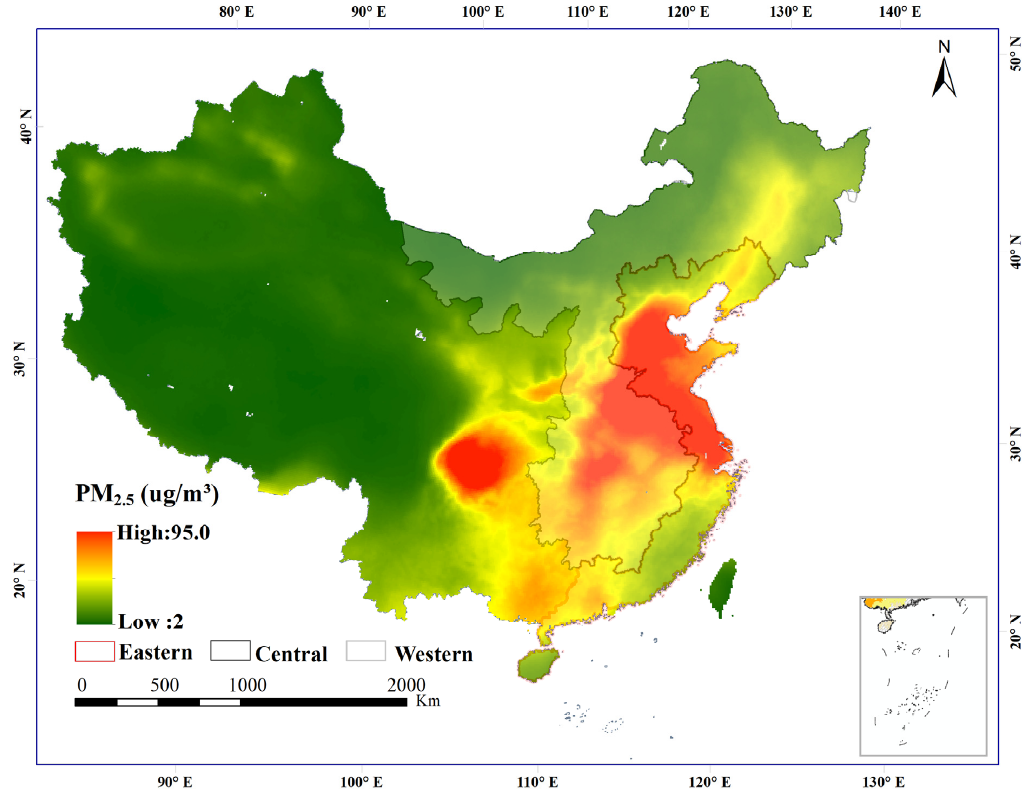
Figure 3. The spatial distribution of the annual average anthropogenic PM 2.5 concentrations in China during 1998–2016. (We used ArcGIS 10.2 software to calculate the average mean of the gridded data of anthropogenic PM 2.5 concentrations from 1998 to